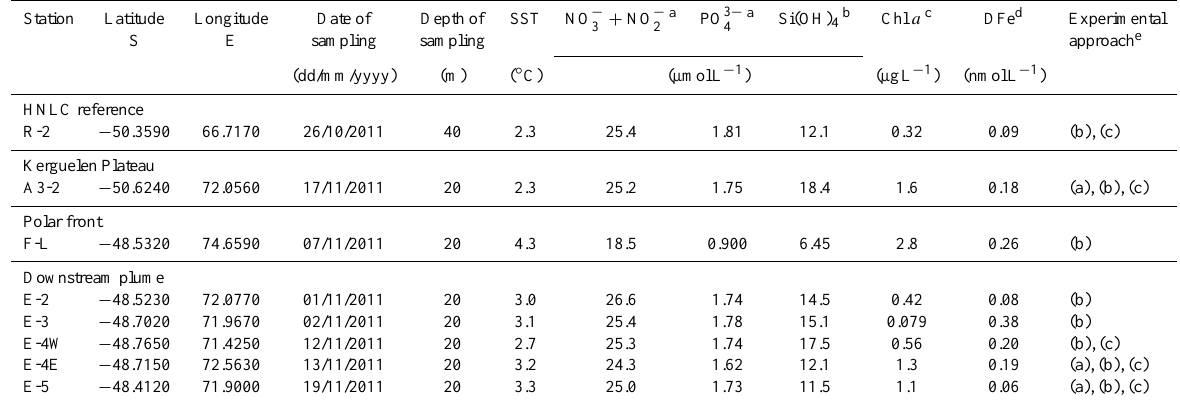
Table 1. Location, date, depth of sampling and main biogeochemical properties from studied stations. Experimental approach column refers to Fig. 2, with (a), (b) and (c) related to incubations including the whole community, pico-nanoplankton plus bacteria, and bacteria only,